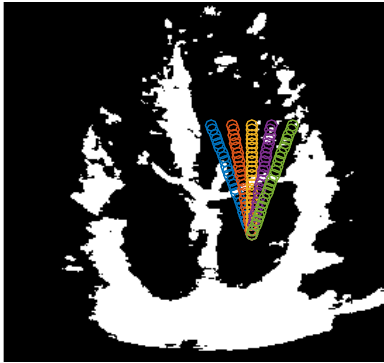
Figure 3. 5 prongs centered at the atrium boundary centroid and spanning 40 ◦